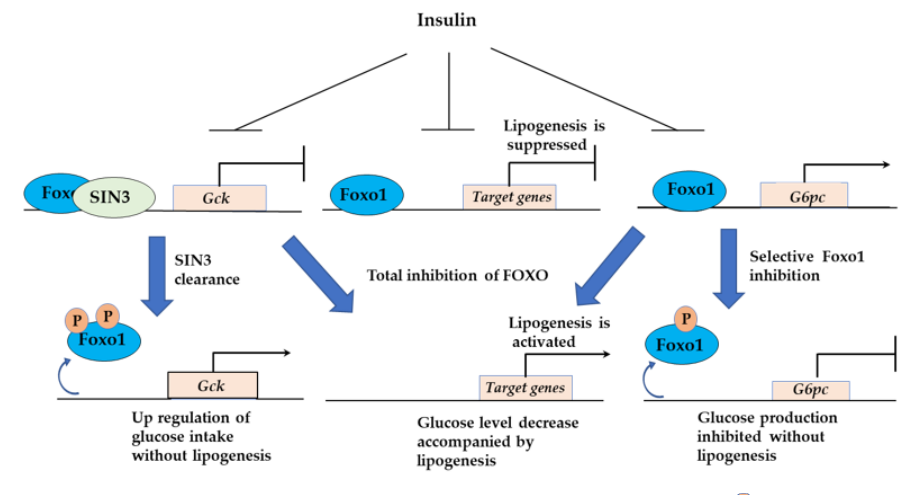
Figure 8. FOXO1 and SIN3 regulate the expression balance of G6pc , Gck , and lipogenesis genes. Insulin induces selective inhibition of FOXO1 and represses G6pc expression. SIN3 clearance selectively activates Gck expression; thus, hepatic glucose utilization is increased and the blood glucose level decreases. Selective inhibition of FOXO1 does not a ff ect the expression of lipogenesis genes suppressed by